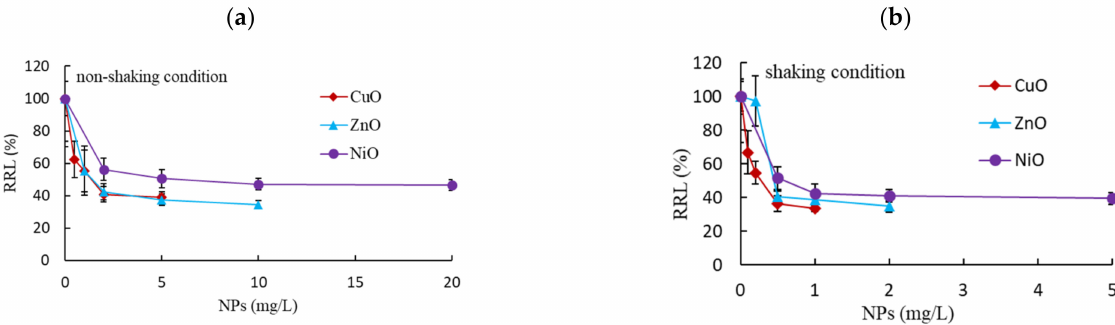
Figure 2. Effects of nanoparticle (NP) exposure on relative root growth (RRL) under ( a ) non-shaking and ( b ) shaking conditions.